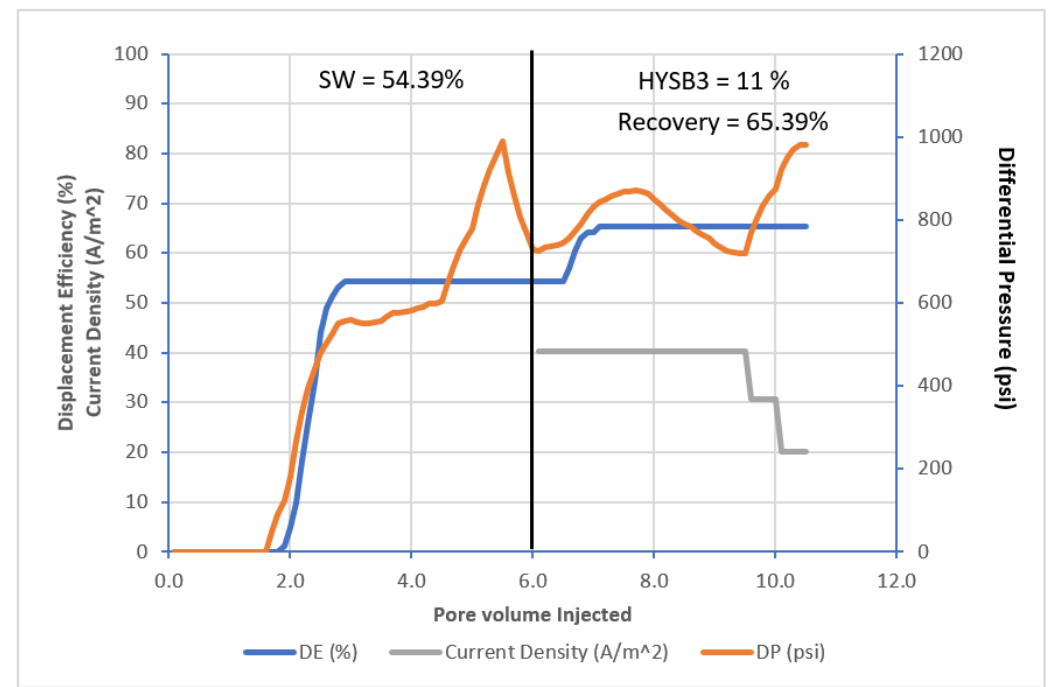
Energies 2022 , 15 , x FOR PEER REVIEW Figure 13. DE, DP ( ∆ P), Current Density vs. Pore Volume Injected for CF11. Figure 13. DE, DP (ΔP), Current Density vs. Pore Volume Injected for CF11 . CF12